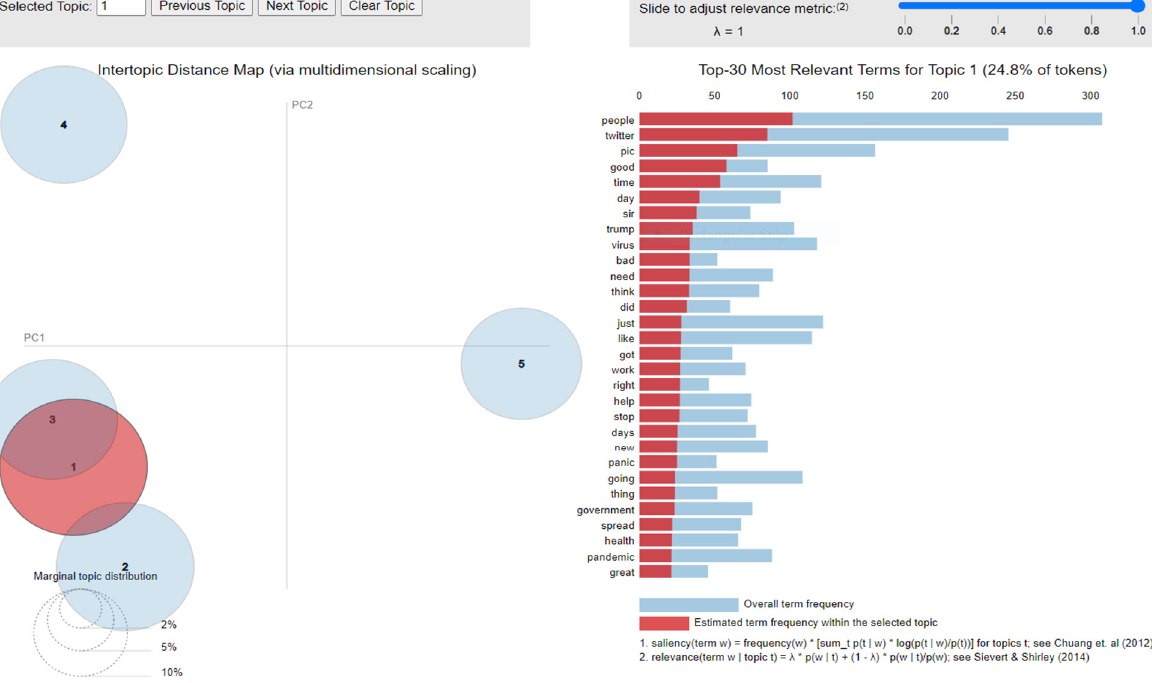
Figure 12. Inter-topic distance map for the second dataset.